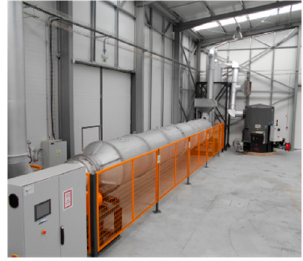
Figure 1. Rotary dryer experimental apparatus.